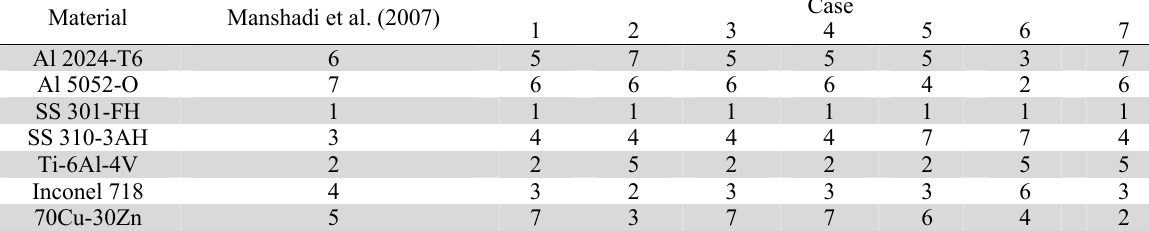
Rankings of cryogenic storage tank materials using TOPSIS method for seven cases Material